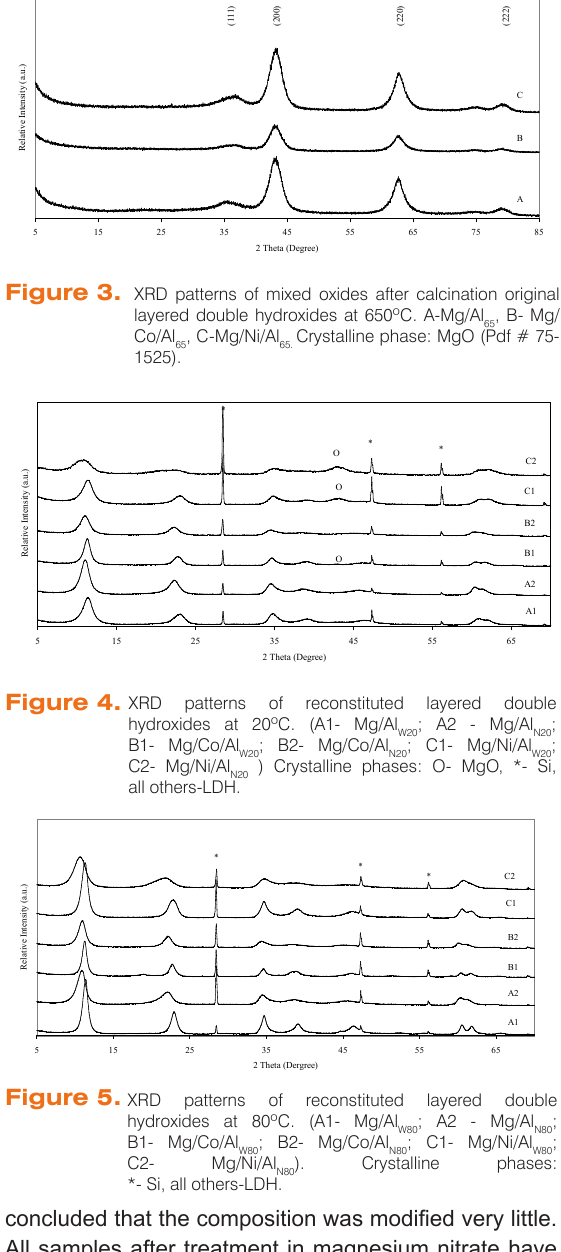
hydroxides at 80ºC. (A1- Mg/Al ; A2 - Mg/Al ; W80 N80 B1- Mg/Co/Al ; B2- Mg/Co/Al ; C1- Mg/Ni/Al ; W80 N80 W80 C2- Mg/Ni/Al ). Crystalline phases: N80 *- Si, all others-LDH.